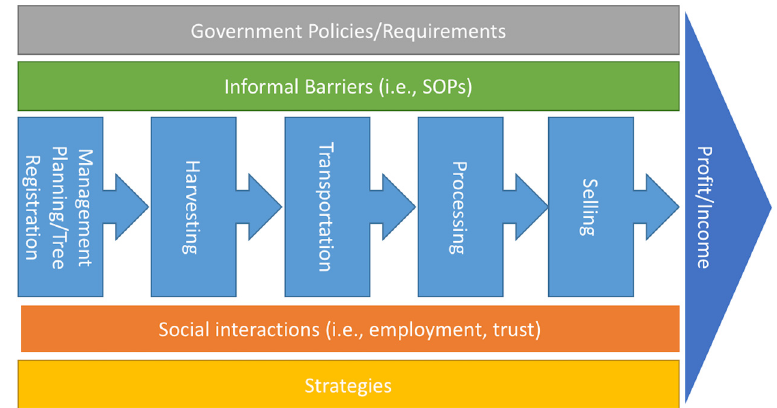
Figure 1. Timber value chain framework on CBTE and smallholder forestry.